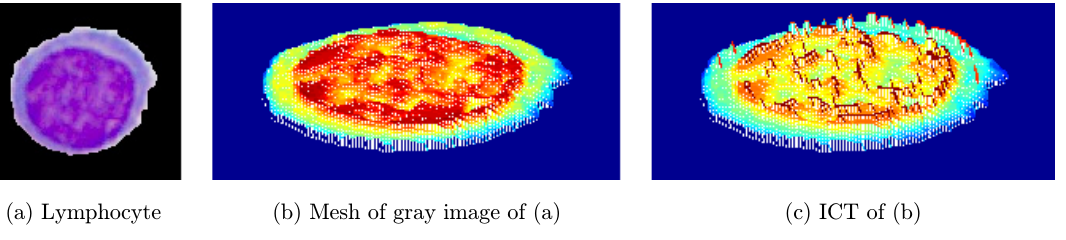
Fig. 7. Clustering of lymphocyte.